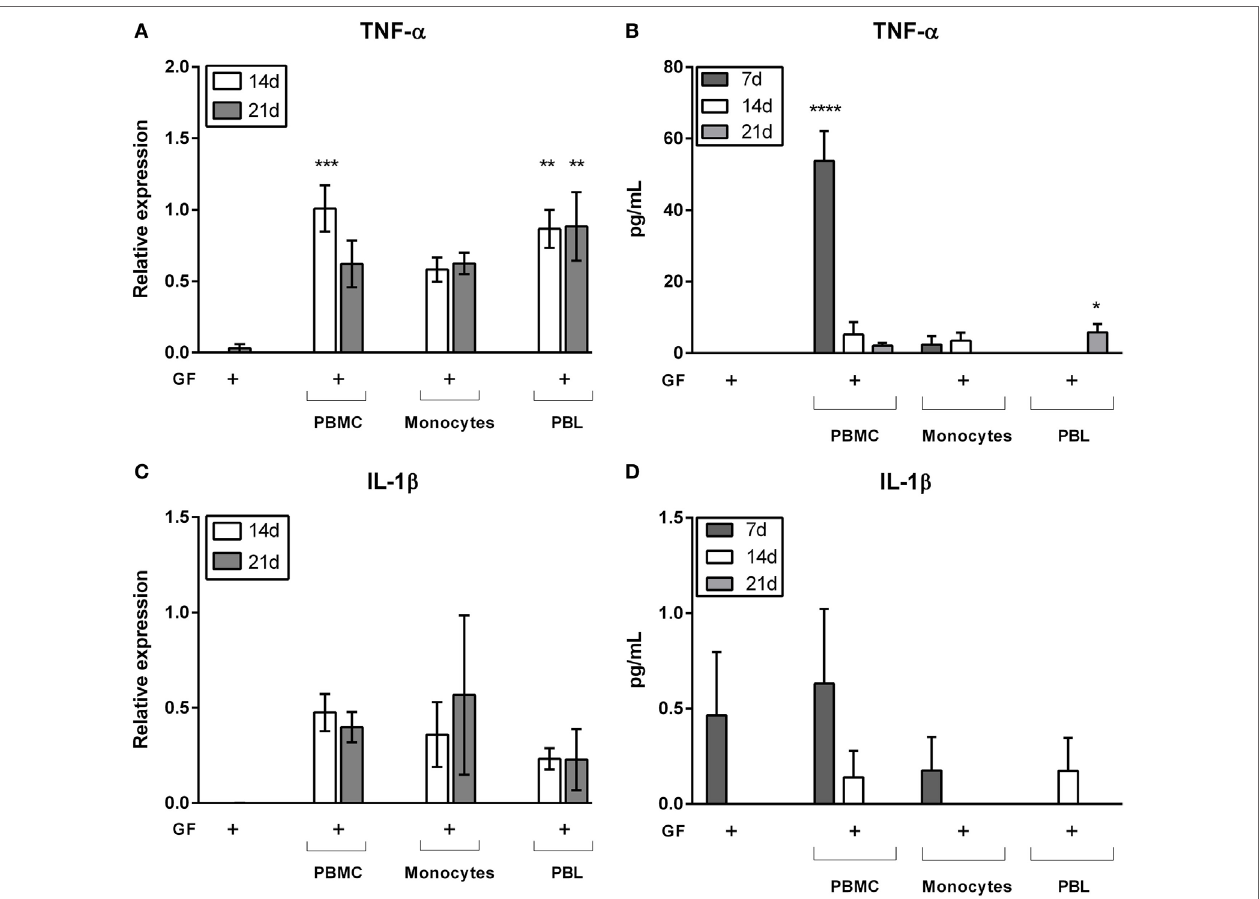
FigUre 7 | Gene expression and cytokine protein levels of tumor necrosis alpha (TNF- α ) and interleukin 1 beta (IL-1 β ). Gene and protein expression of inflammatory cytokines (a,B) TNF- α and (c,D) IL-1 β . Relative gene expression of inflammatory cytokines (a) TNF- α and (c) IL-1 β after 14 (white bars) and 21 days (gray bars) of culture. Protein levels (pg/mL) of (B) TNF- α and (D) IL-1 β after 7 (dark gray bars), 14 (white bars), and 21 days (gray bars). TNF- α (a) gene expression levels are significantly increased in gingival fibroblast (GF)-peripheral blood mononuclear cell (PBMC) cocultures (14 days) and GF-peripheral blood lymphocyte (PBL) cocultures (14 and 21 days) in comparison to GF monocultures. TNF- α (B) protein levels are significantly increased in GF-PBMC cocultures (7 days) and GF-PBL cocultures (21 days) in comparison to GF monocultures. No significant differences were found for IL-1 β gene expression (c) and protein levels (D) . All genes are expressed relative to the geometric mean of housekeeping genes hypoxanthine phosphoribosyltransferase and porphobilinogen deaminase. Data are presented as means ± SEM. All significant differences were compared to GF monocultures. n = 6 GF donors for gene expression data, n = 5 GF donors for cytokine quantification data, * p < 0.05, ** < 0.01, *** < 0.001, **** <